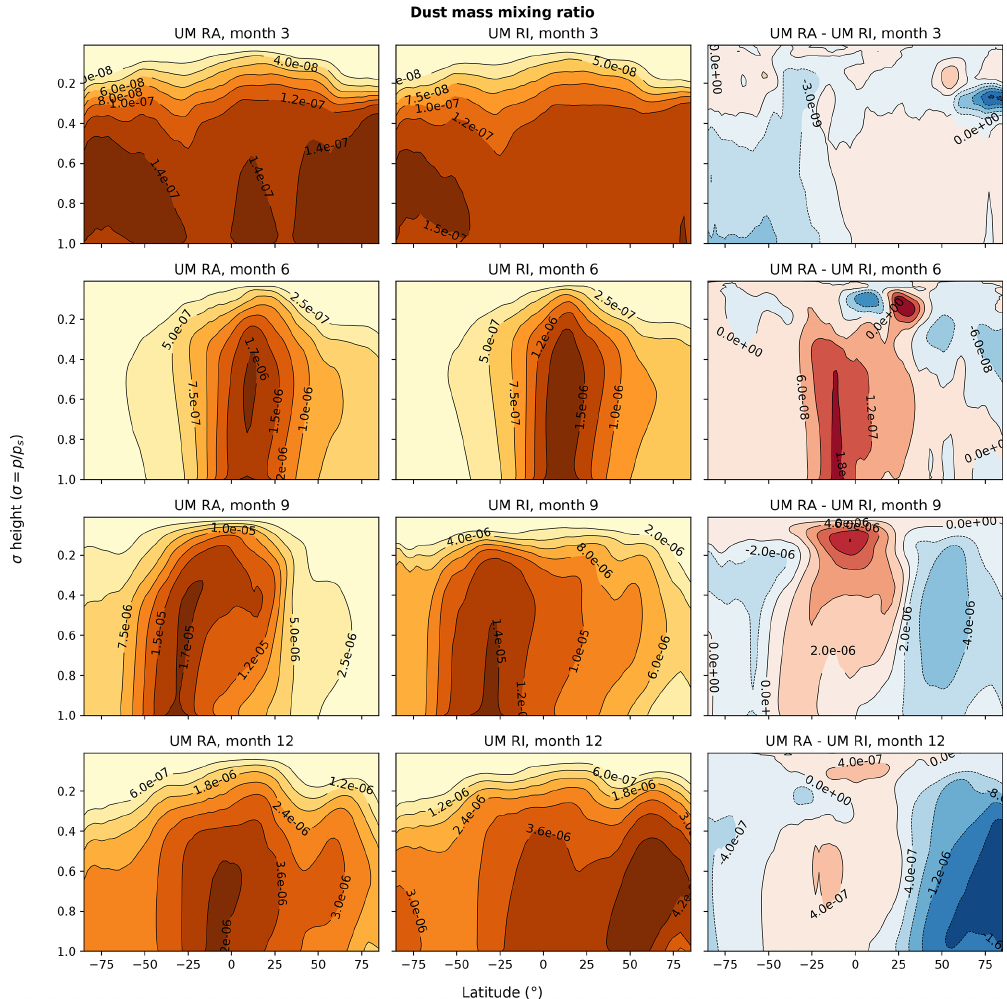
Figure A4. Zonal mean dust mass mixing ratio (kgkg − 1 ) across four seasons within the Martian year; each month is the average taken of all sols within that month (months according to Table A1). The RA dust scenario is shown on the left, the RI dust scenario in the centre and the differences between scenarios on the right. Contour lines denote the mass mixing ratio and units are in kgkg − 1 . Note that, due to the wide range of values present between months, the colour-scale ranges differ between months and scenarios for this